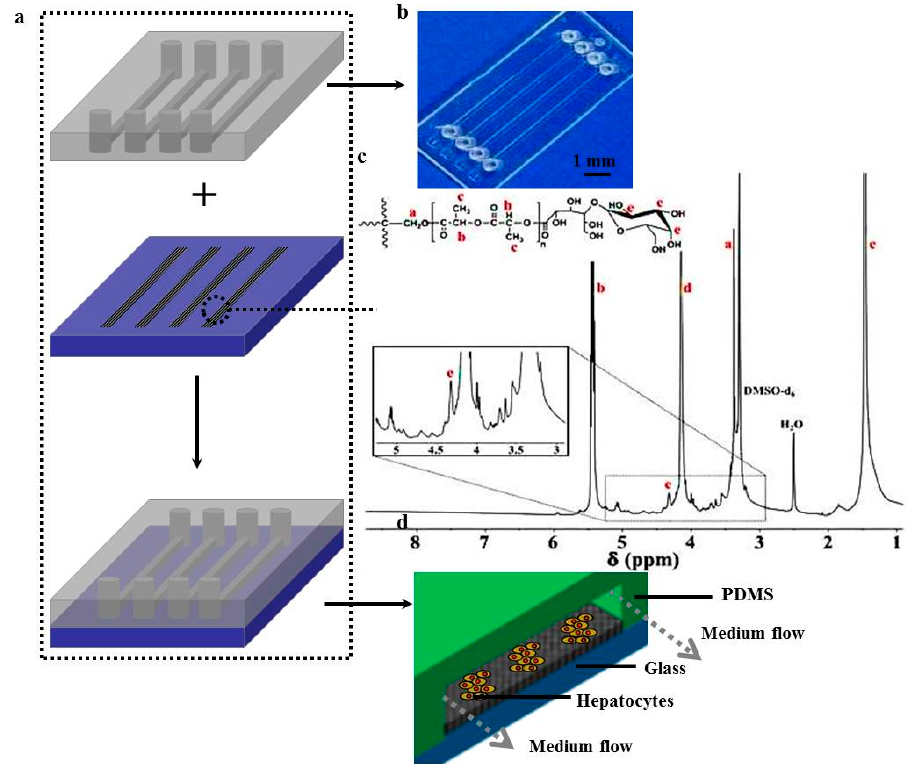
Figure 1. ( a ) Schematic illustration of a microfluidic device assembly; ( b ) digital image of the fiber-based microfluidic chip; ( c ) 1 H-NMR spectrum of lactosylated poly( DL -lactide) (lac-PLA); ( d ) 3D schematic illustration of the microfluidic device.